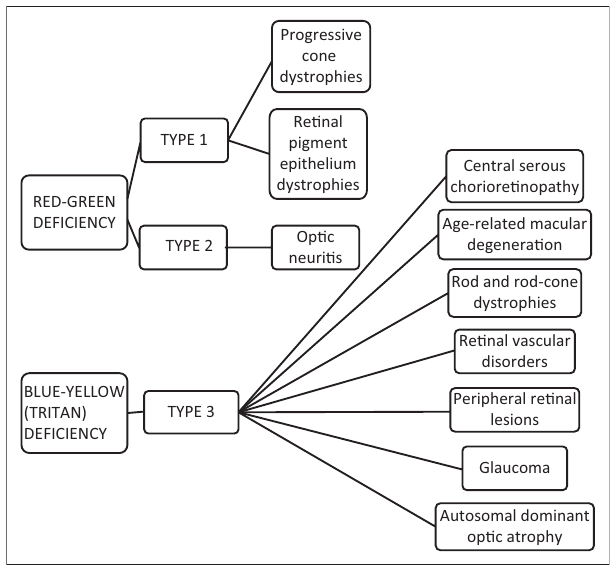
FIGURE 2: Flow diagram illustrating the classification of acquired colour vision deficiencies and associated ocular